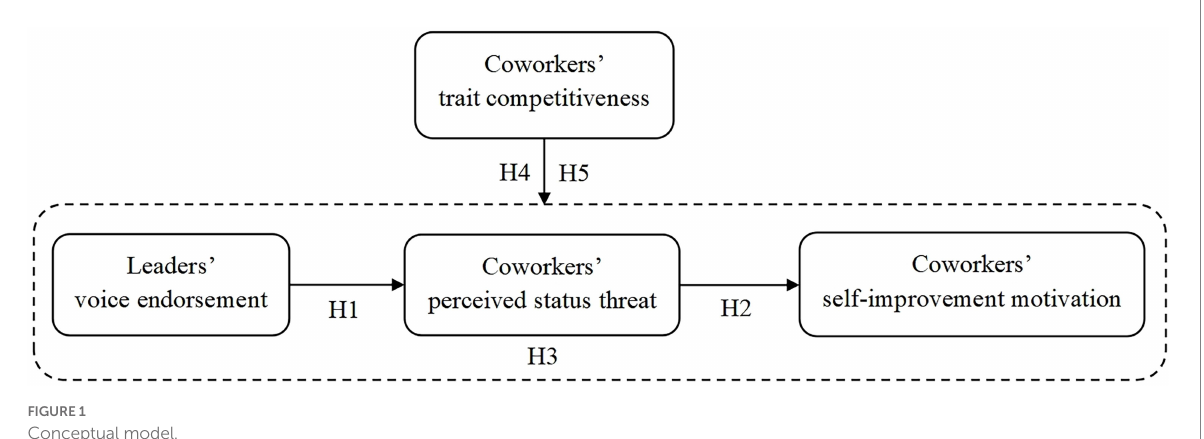
FIGURE 1 Conceptual